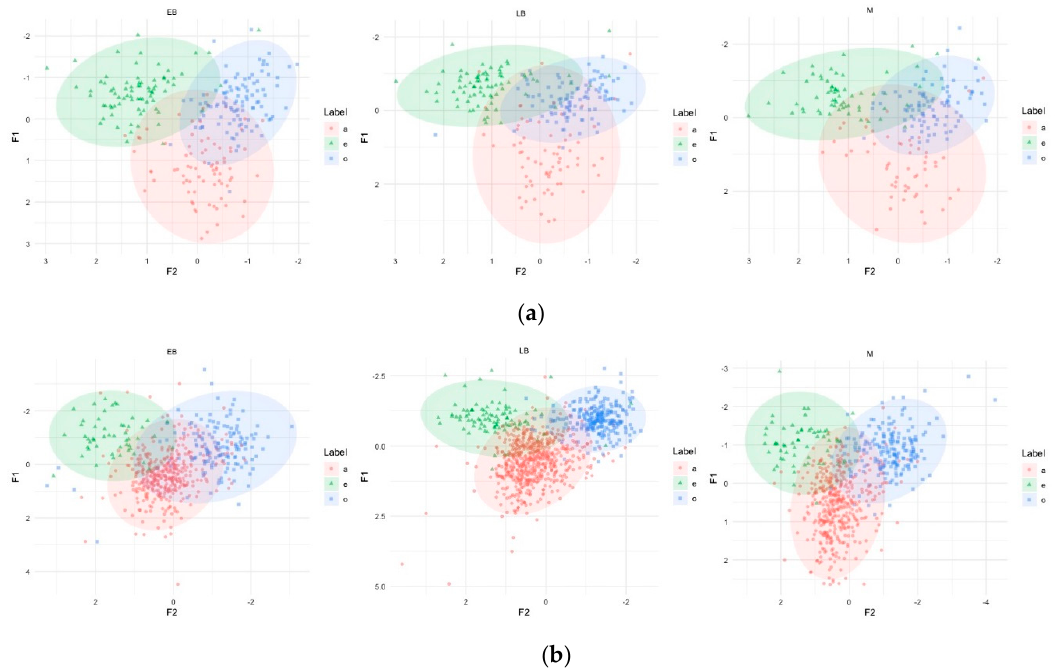
Figure 1. Formant charts for /a e o/ in all groups (Early Bilinguals (EB), Late Bilinguals (LB) and Monolinguals (M)): ( a ) reading task; ( b ) narrative.